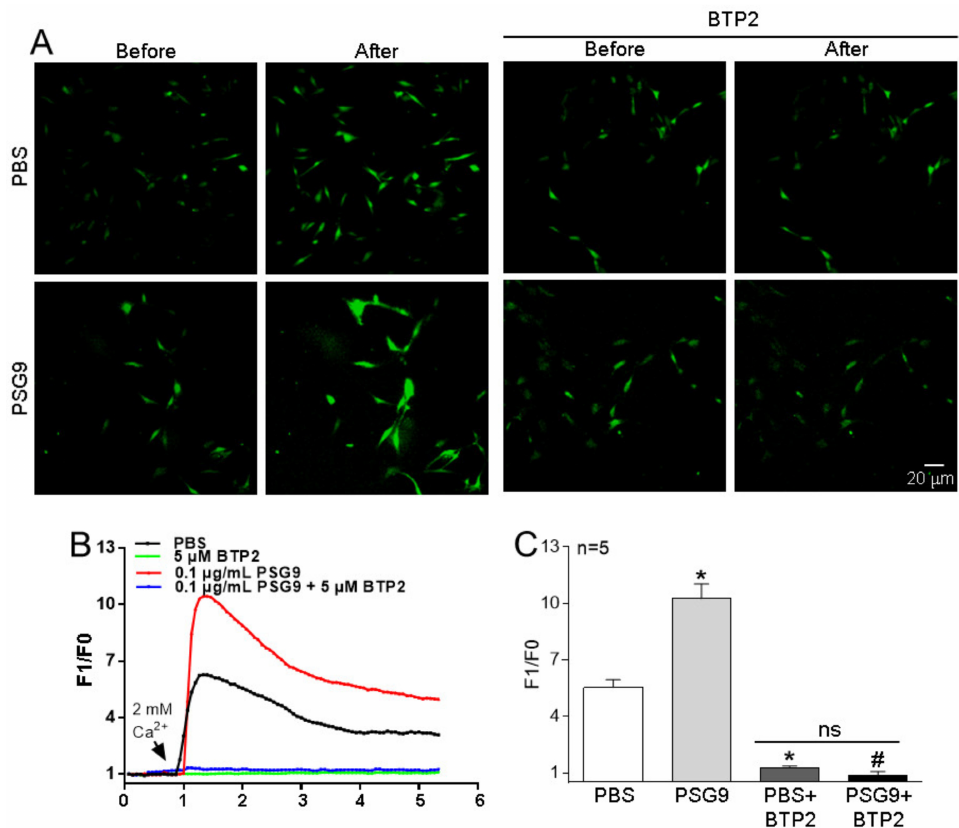
Figure 3. Effect of PSG9 on store-operated Ca 2+ entry (SOCE) in human umbilical vein endothelial cells (HUVECs). ( A – C ) Representative images ( A ), traces ( B ), and summary data ( C ) showing SOCE- mediated intracellular Ca 2+ rising after application of PBS, BTP2 (5 µ M) + PBS, 0.1 µ g/mL PSG9, and 0.1 µ g/mL PSG9 + BTP2 (5 µ M) in HUVECs. To assess SOCE, HUVECs were placed in a Ca 2+ -free solution, and the Ca 2+ stores were depleted by application of 2 µ M thapsigargin. SOCE was evoked by application of 2 mM Ca 2+ to the medium. Values are shown as the mean ± SEM ( n = 5 as indicated). * p < 0.05 compared with PBS; # p < 0.05 compared with PSG9; ns, no significant